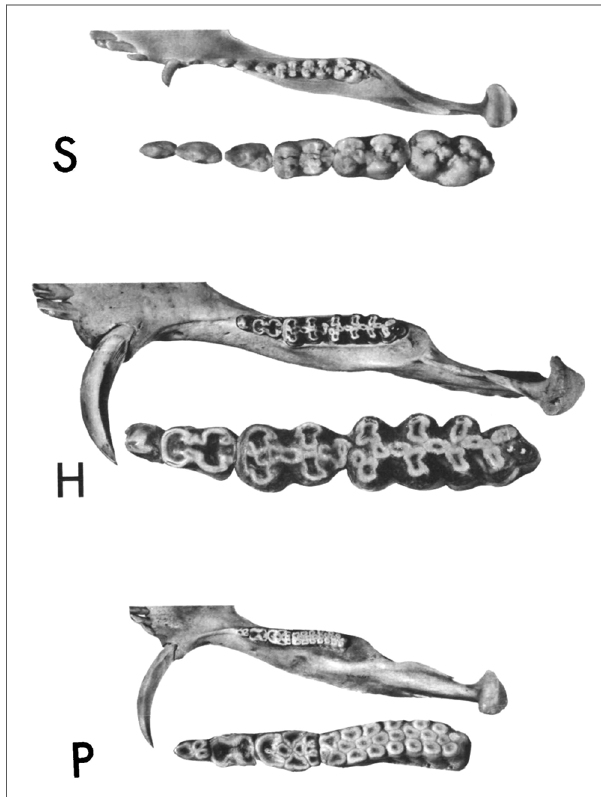
FIGURE 5 Occlusal views of the left mandibular halves of the pig, Sus (S), the